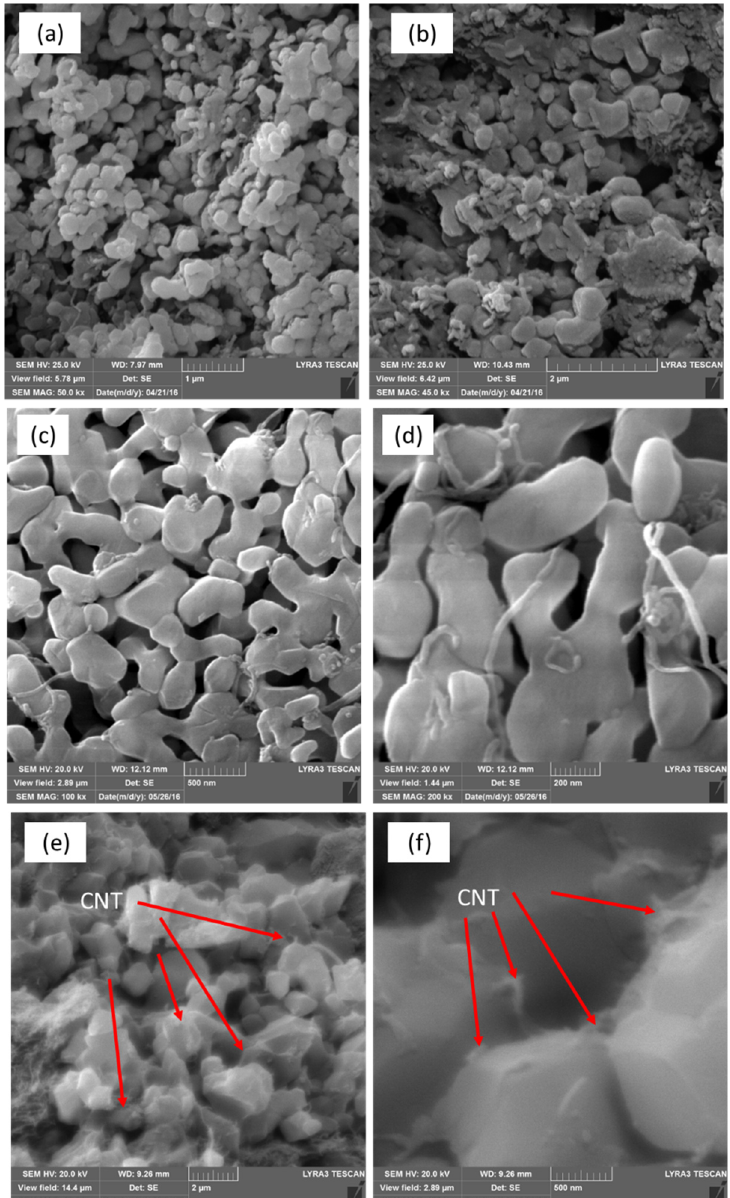
Figure 5. FE–SEM images of the membranes sintered at different SPS process parameters: ( a ) 5.6 MPa, 1000 °C, 10 min, 100 °C/min, and ( b ) 10 MPa, 1000 °C, 10 min, 100 °C/min; ( c,d ) 10 MPa, 1100 °C, 5 min, 200 °C/min; ( e,f ) 10 MPa, 1000 °C, 10 min, 50 °C/min.